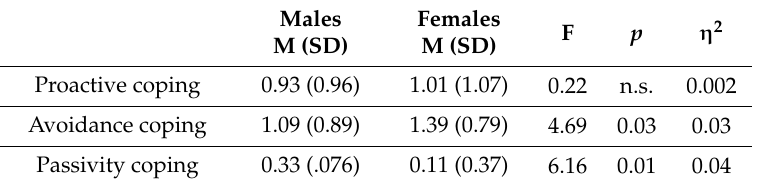
Table 3. Coping strategies: comparison on the basis of gender (one-way